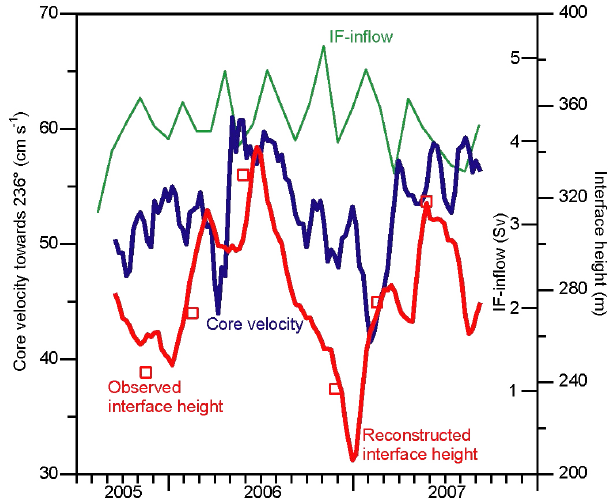
Figure 9. Comparison of core velocity (towards 236 ◦ ) at site IFRI and interface height at station K4 above the sill level of the IFR close to Iceland ( h u ) as well as IF-inflow. Continuous lines repre- sent 4-weekly averaged core velocity (blue), reconstructed interface height (red), and IF-inflow (green). Red rectangles indicate interface height based on the observed interface depth at K4.